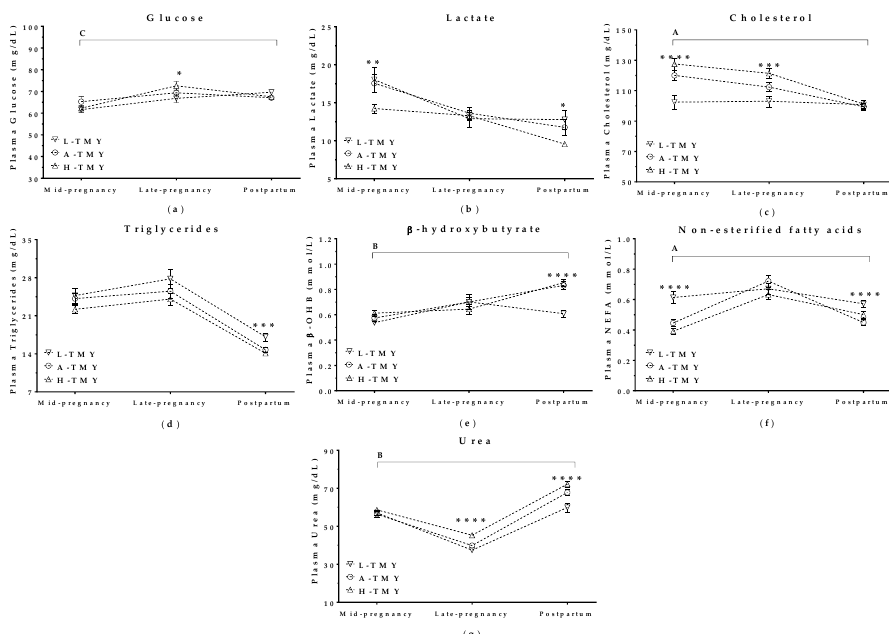
Figure 4. Plasma glucose ( a ), lactate ( b ), cholesterol ( c ), triglycerides ( d ), β -hydroxybutyrate ( e ), non-esterified fatty acids ( f ), and urea ( g ) in mature ewes with high, average, or low total milk yield during concurrent gestation and lactation and in the postpartum period. L-TMY: low-yielding sheep with a TMY (total Milk Yield) < 220 L / lactation; A-TMY: average yielding sheep (220–371 L); H-TMY: high-yielding sheep ( > 371 L). Data are mean ± SEM. Significant interactions between pregnancy / postpartum stage and TMY are represented by an upper horizontal line and capital letters (A: p < 0.0001, B: p < 0.001, and C: p < 0.05). Asterisks indicate significant di ff erences between groups at each time point (**** p < 0.0001; *** p < 0.001; ** p < 0.01; * p < 0.05). There was no correlation between YDIMd ( p > 0.05) or YDIMc ( p > 0.05) and maternal metabolite